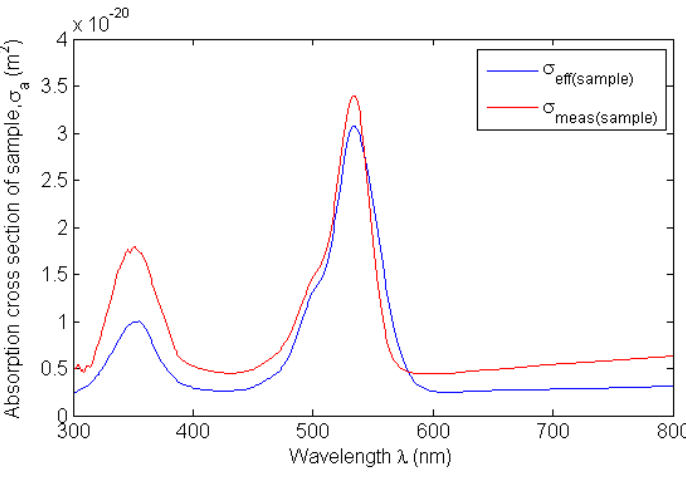
Figure 10. Sample absorption cross